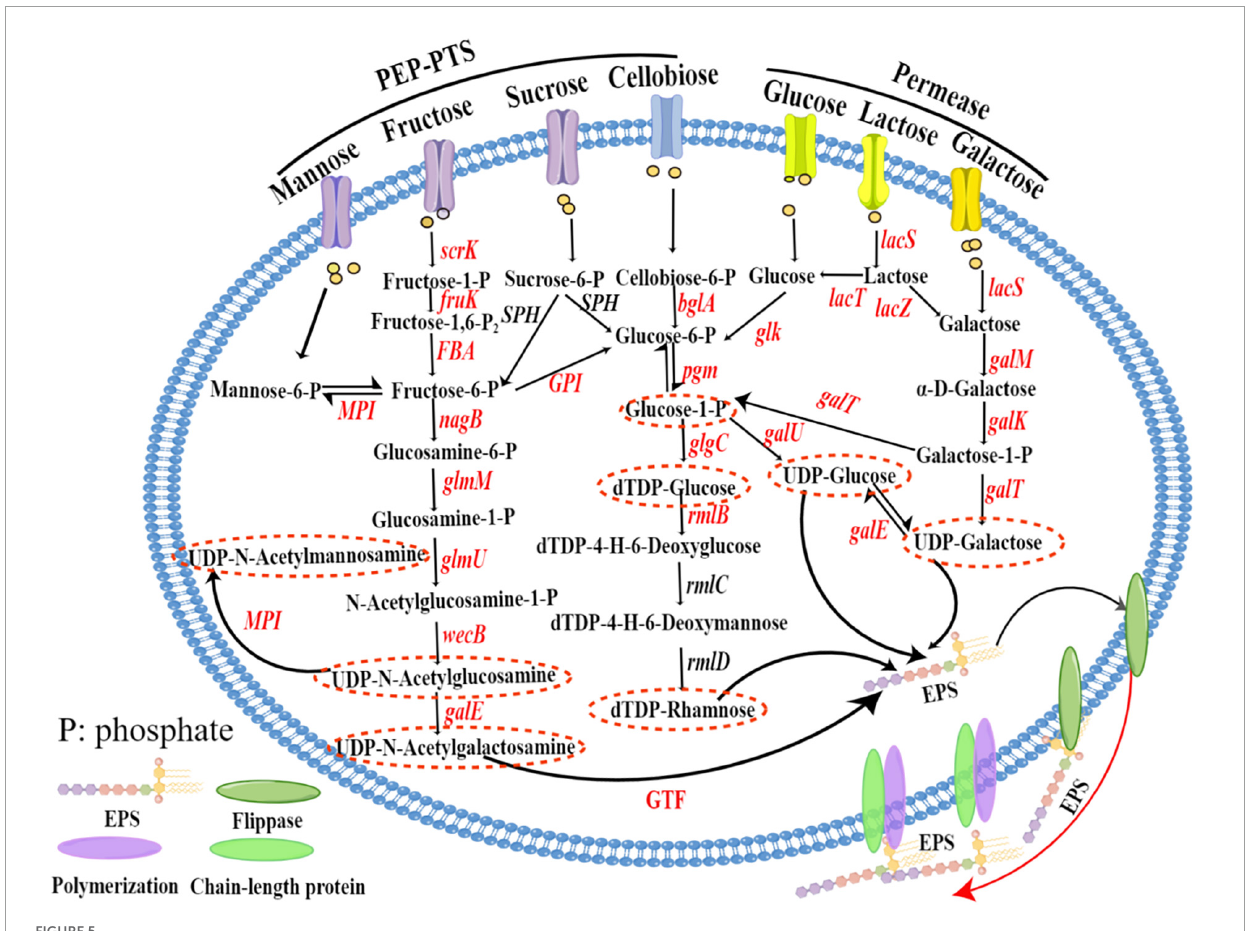
FIGURE5 Nucleotide sugar biosynthesis pathways of Lp. plantarum MC5. Nucleotide sugar biosynthesis pathways mapped by Figdraw (https://www.figdraw.com/static/index.html#/). Annotated genes are marked in red, and the nucleotide sugars are in red dashed ovals. scrK , fructokinase; SPH , sucrose-6-phosphate hydrolase; GPI , glucose-6-phosphate isomerase; bglA , 6-phosphate- β -glucosidase; pgm , phosphoglucomutase, galU , UTP-glucose-1-phosphate uridylyltransferase; galE , UDP-glucose 4-epimerase; glgC , glucose-1-phosphate adenylyltransferase; rmlB , dTDP-glucose-4,6-dehydratase; rmlC , dTDP-4-dehydrorhamnosac-3,5-epimerase; rmlD , dTDP-4-dehydrorhamnorea reductase; glk , glucokinase; lacS , lactose/galactose permease; lacZ , β -galactosidase; galM , aldose 1-epimerase; galK , galactokinase; galT , UDP-glucose-hexose-1-phosphate uridylyltransferase; fruK , 1-phosphofructokinase; FBA , fructose-bisphosphate aldolase; nagB , glucosamine-6-phosphate deaminase; glmM , phosphoglucosamine mutase; glmU , glucosamine-1-phosphate N -acetyltransferase; wecB , UDP-N-acetylglucosamine 2-epimerase (non-hydrolyzing); MPI , mannose-6-phosphate isomerase; GTF,